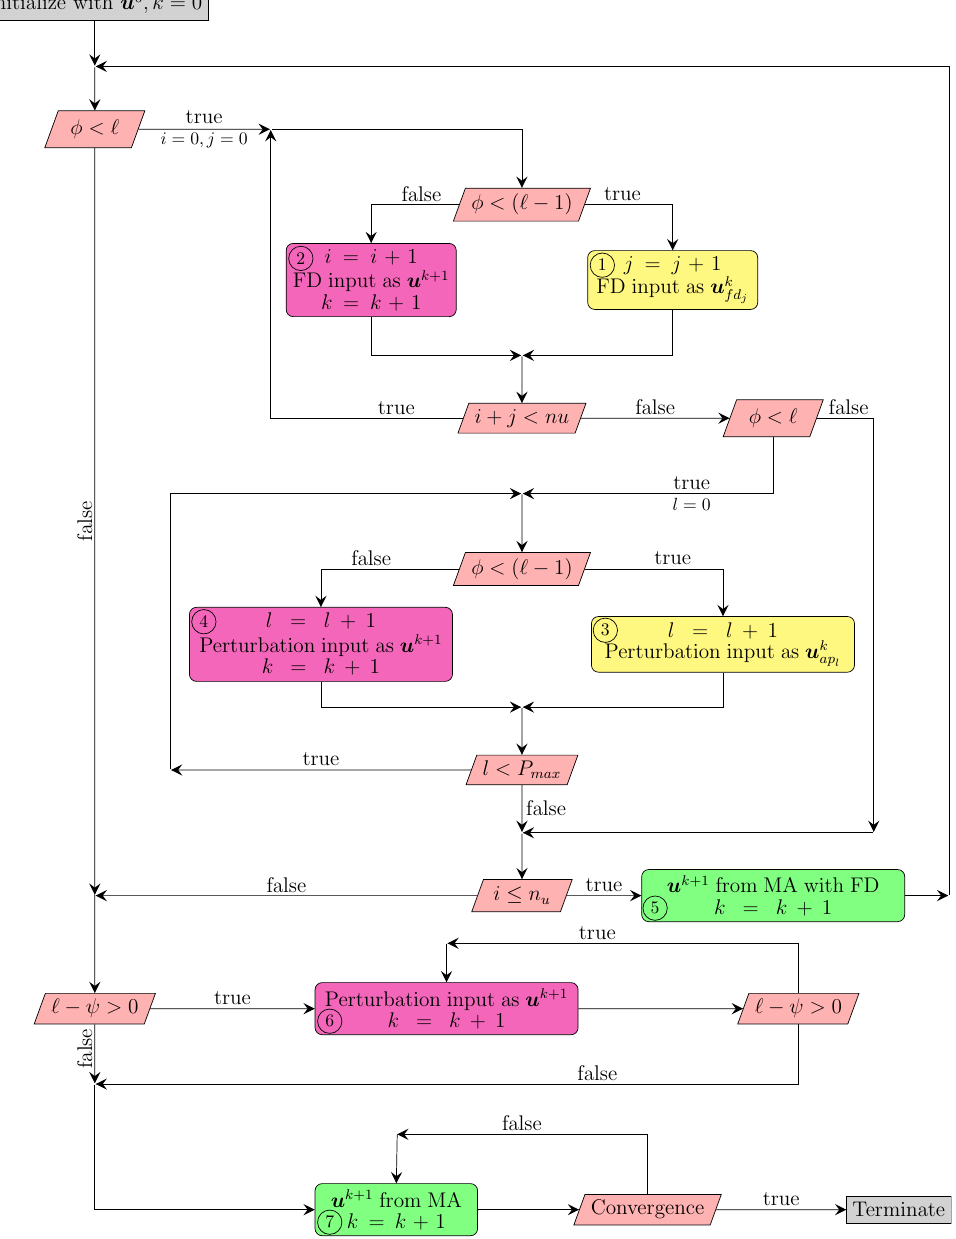
Figure 6. Flowsheet for proactive perturbation scheme for